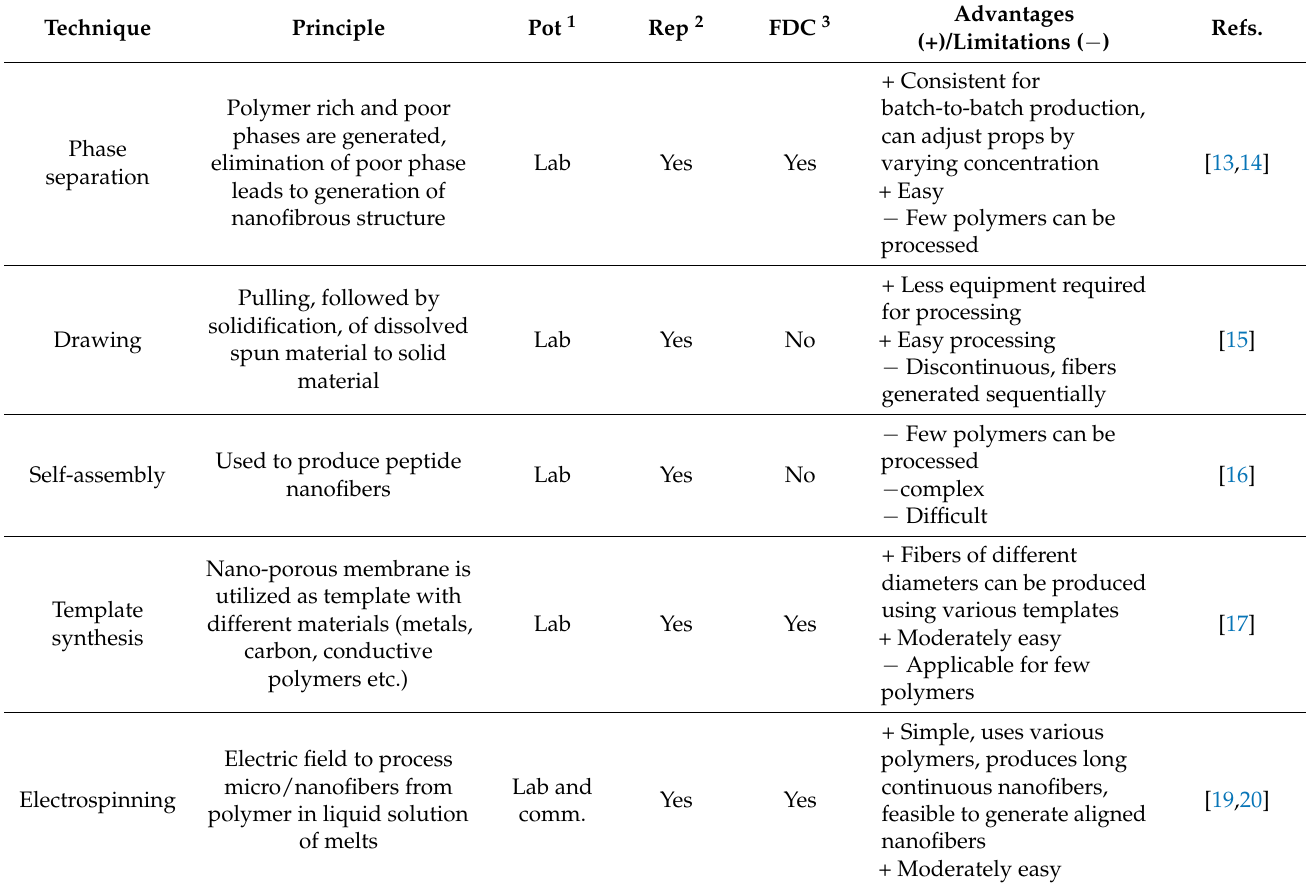
Table 1. Different techniques for polymer nanofibers production, from different